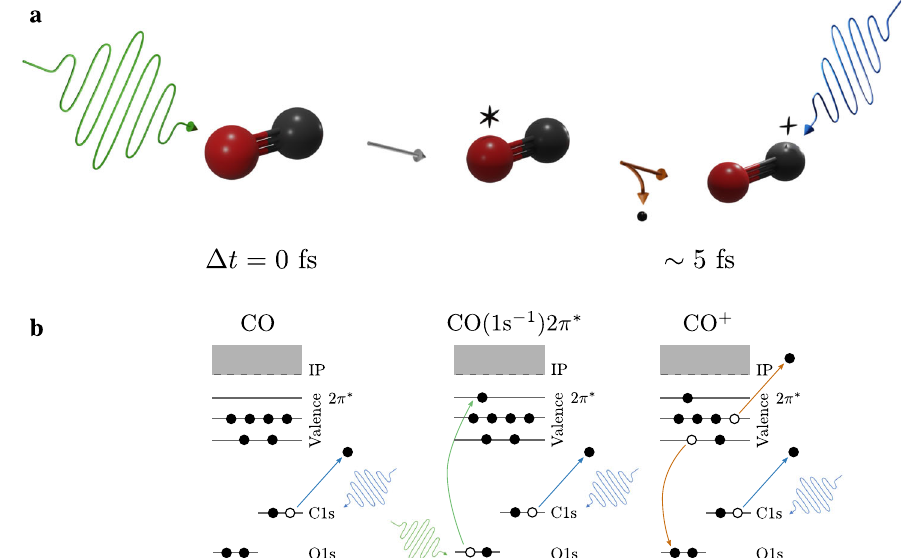
Fig. 1 | Site-selective two-color femtosecond x-ray pump-probe scheme to fol- low ultrafast chemical shifts in CO. a The x-ray pump (green) excites the O 1 s electron,leadingtotheformationofCO(1 s − 1 )2 π * ,whichsubsequentlydecaysinfew femtoseconds via Auger processes (orange) to CO + . A time-delayed x-ray pulse